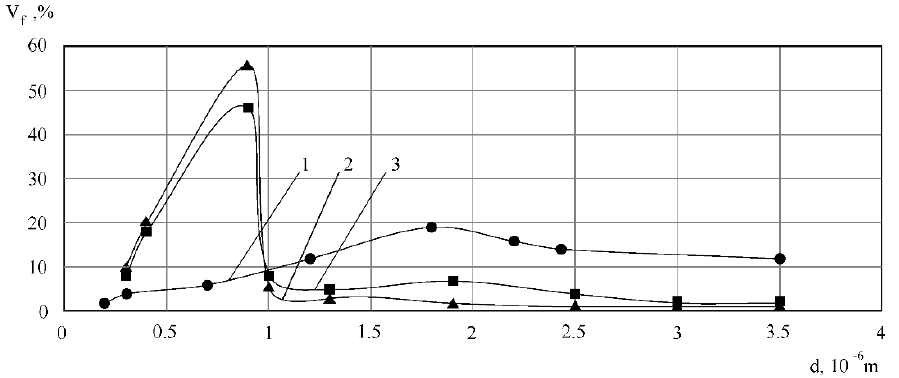
Figure 4. Volume distribution of the fat globules according to their sizes: 1—non-homogenized milk; 2—milk after the valve homogenization; 3—milk after treatment in the cavitation device.